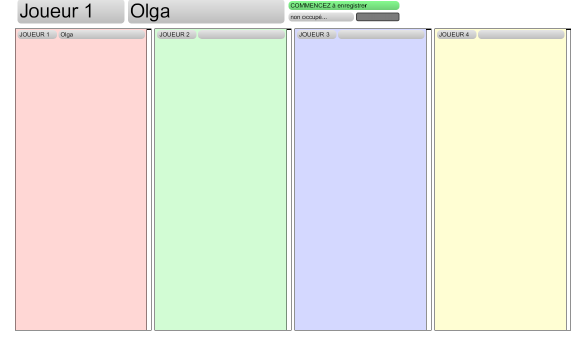
3 | Fig. 3. – Client patch. Joueur [Participant], Com- mencez à enregistrer [Start